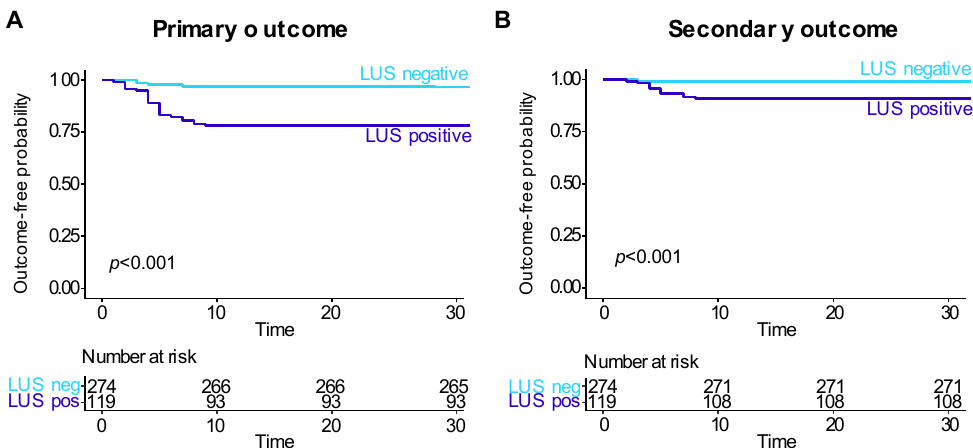
Figure 3. ROC curve analysis for prediction of ( A ) primary outcome and ( B ) secondary outcome.